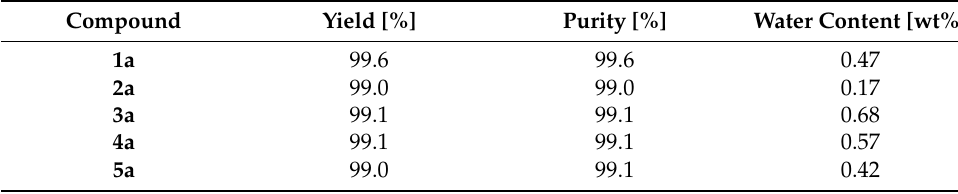
Table 1. Parameters of the synthesis of HMTA derivatives.